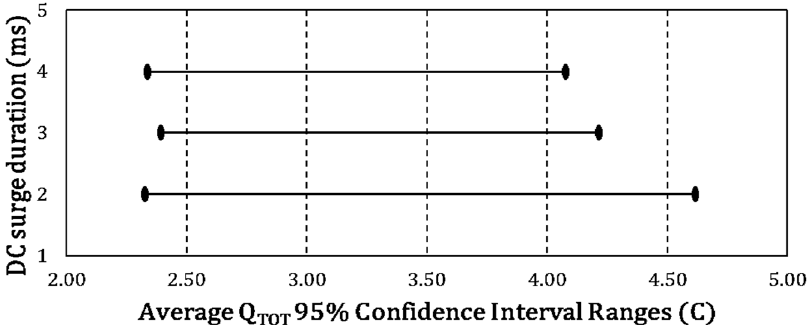
Figure 7. YZ manufacturer visual comparison of confidence interval ranges.